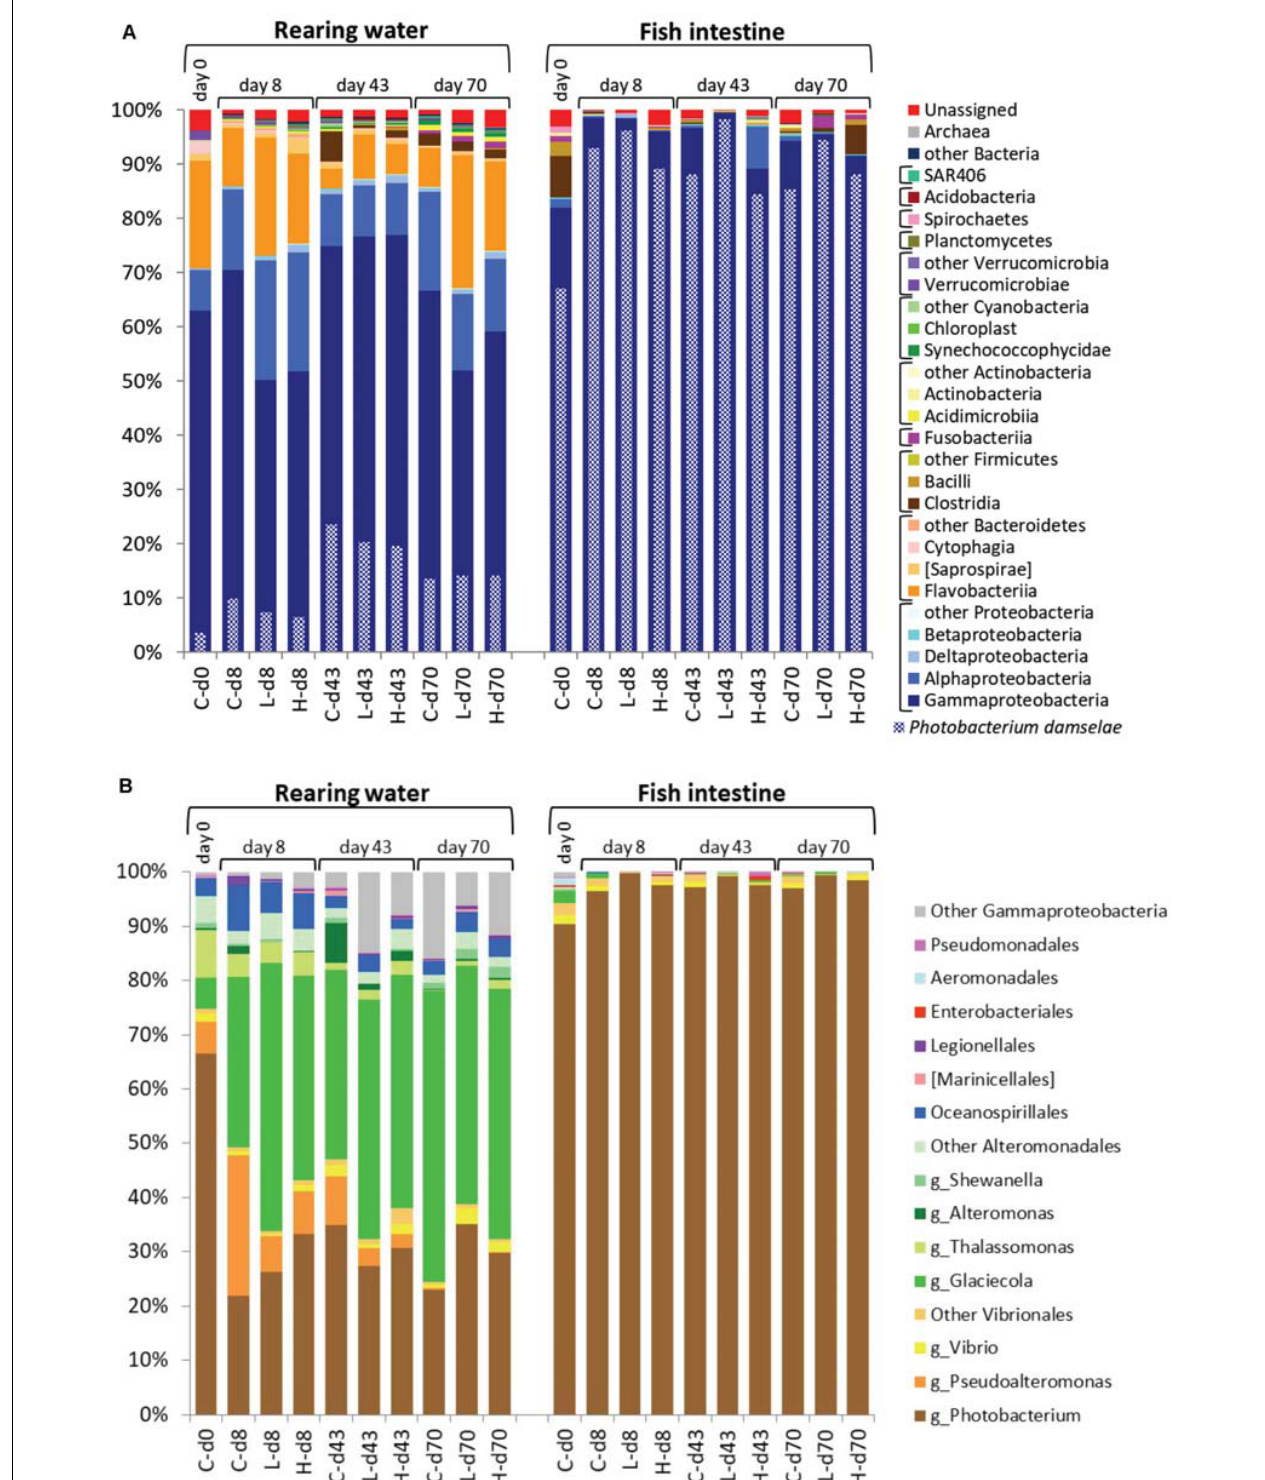
FIGURE 7 | Prokaryotic community structure (abundance rate) in the rearing water and fish intestine. (A) Phylum-Class level in the whole community. Photobacterium damselae abundances are indicated with checkered bars. (B) Order level in the Gammaproteobacteria with some major genera indicated. DNA samples from the same experimental tank on the same day were combined. In the inserted legend, “g_” indicates genus. At the bottom of each panel, the sample names for each bar are coded as follows: C, control; L, low-OTC; H, high-OTC; d and number, days after initiation of study.